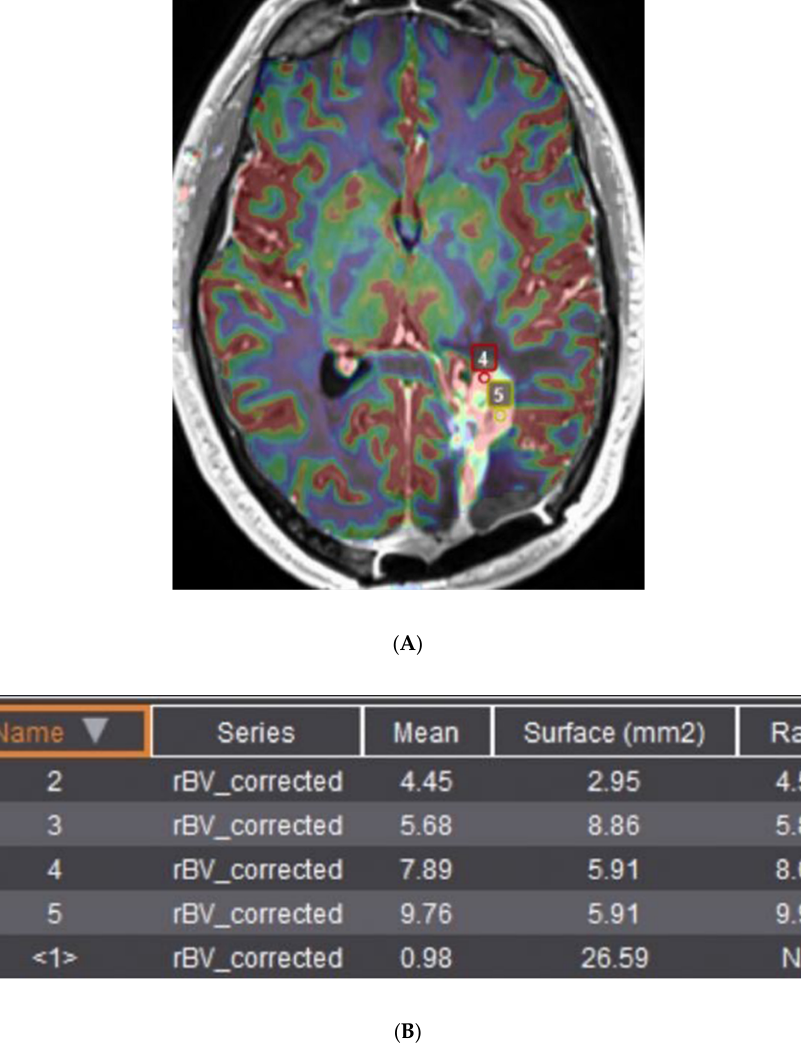
Figure 3. ( A ) Relative cerebral blood volume map superimposed on a gadolinium-enhanced MPRAGE image in a patient with recurrent GBM in the periatrial white matter and occipital lobe. ( B ) Ratios of corrected relative cerebral blood volume (2–5) relative to normal appearing white matter (<1>) are elevated, suggesting recurrent viable tumor rather than treatment effect. Points 1–3 not shown for brevity.